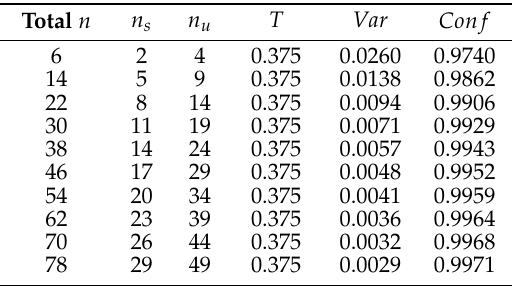
Table 4. Same trust values with different samples of trust